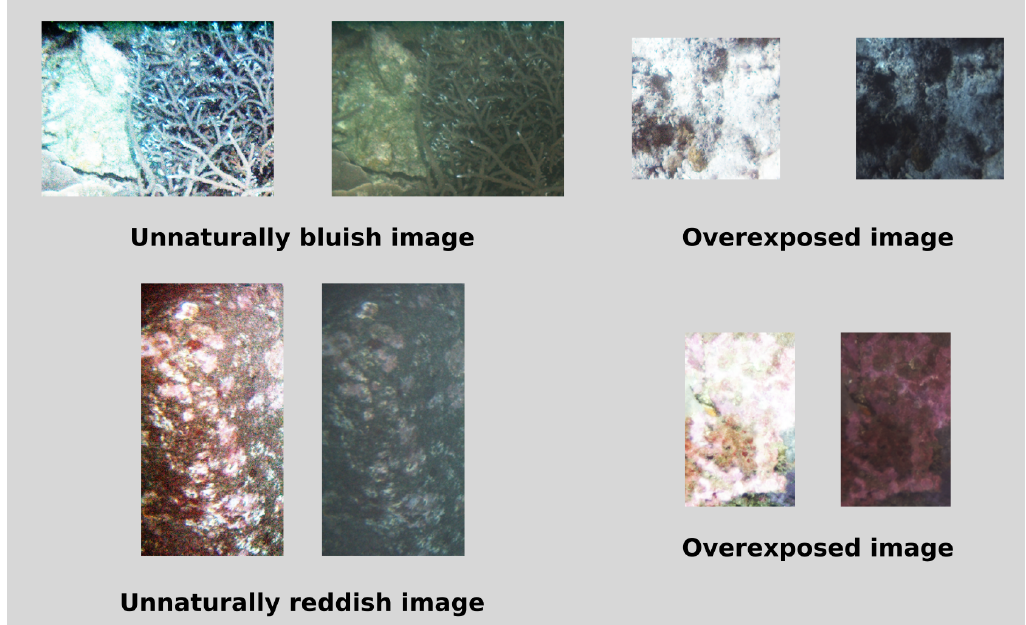
Figure 7. Comparison of histogram equalized only ( left ) and previously dehazed image ( right ) in images that produced different